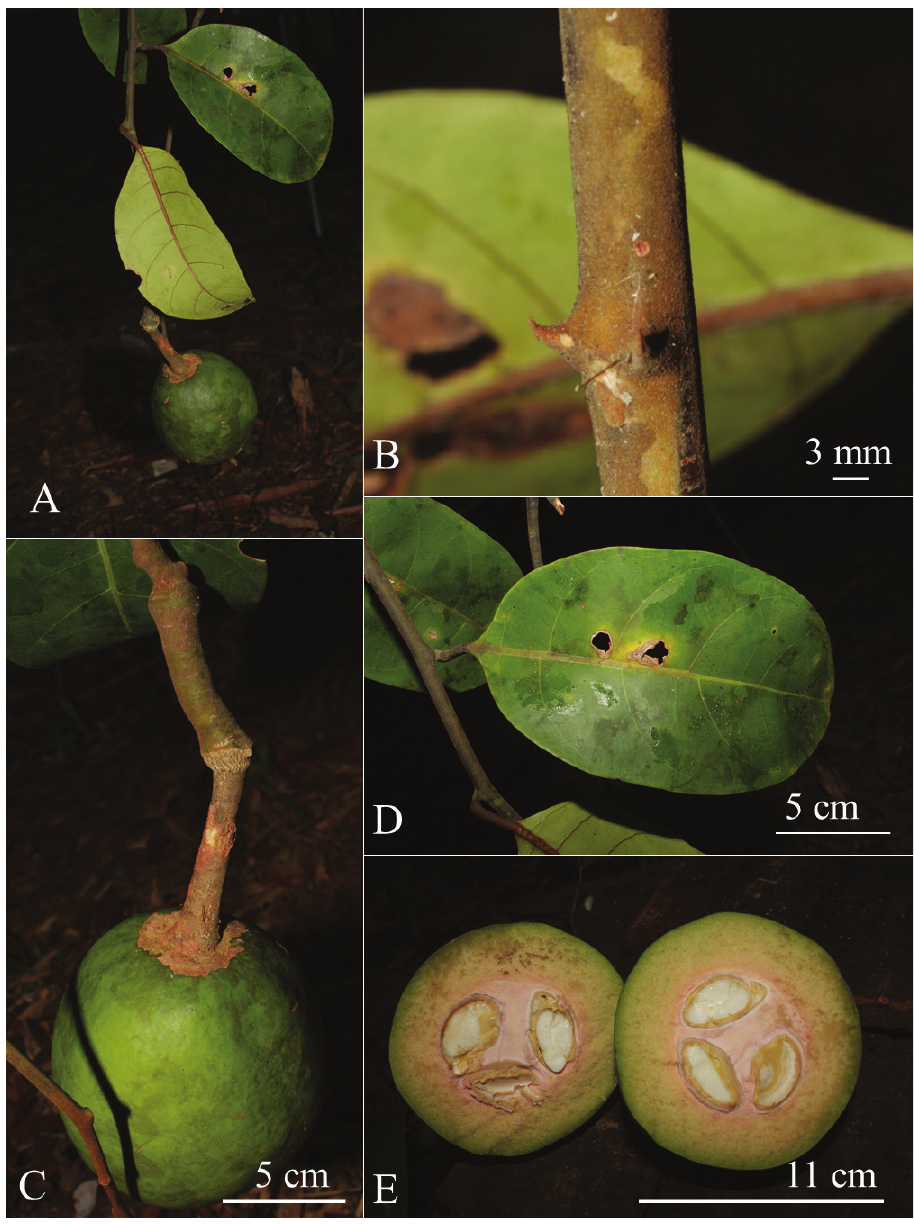
Figure 8. Capparis trinervia var. chungiana Julius, var. nov. A fruiting twig B stipular thorns C young fruit on stout gynophore D leaf E young fruit, cross section. (Photographs by K.